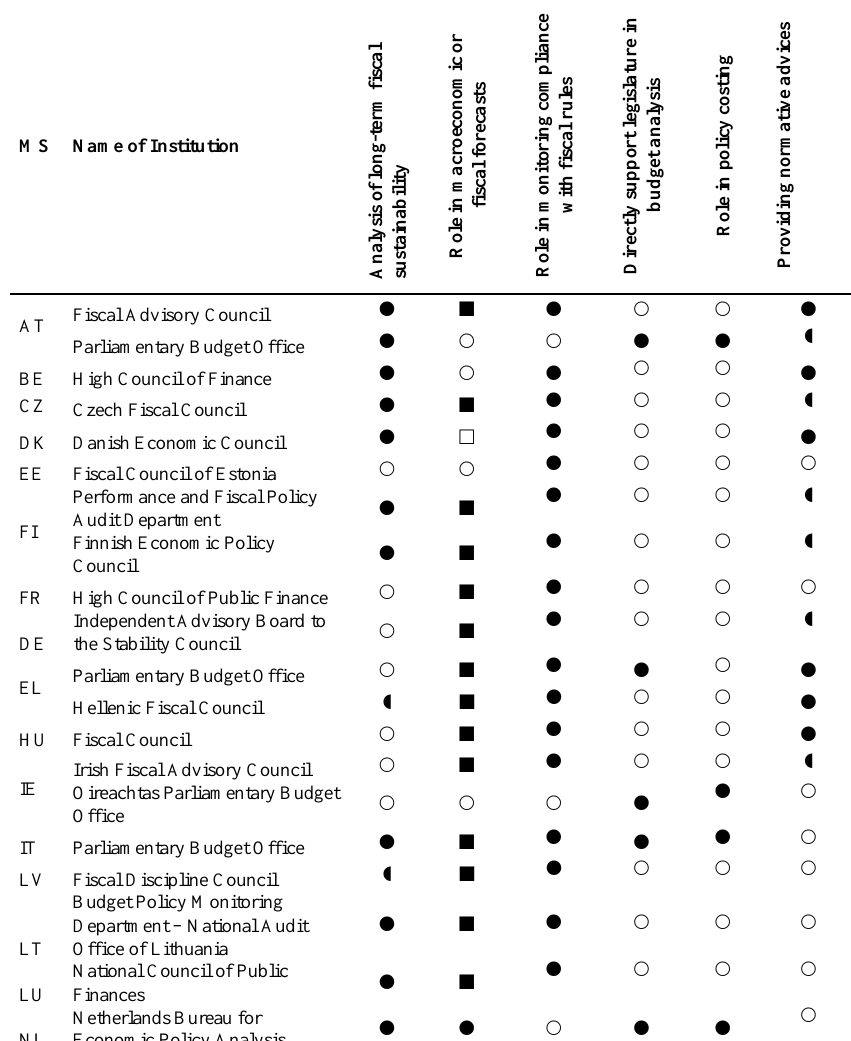
Table 1. Functions of fiscal institutions in the selected EU–28